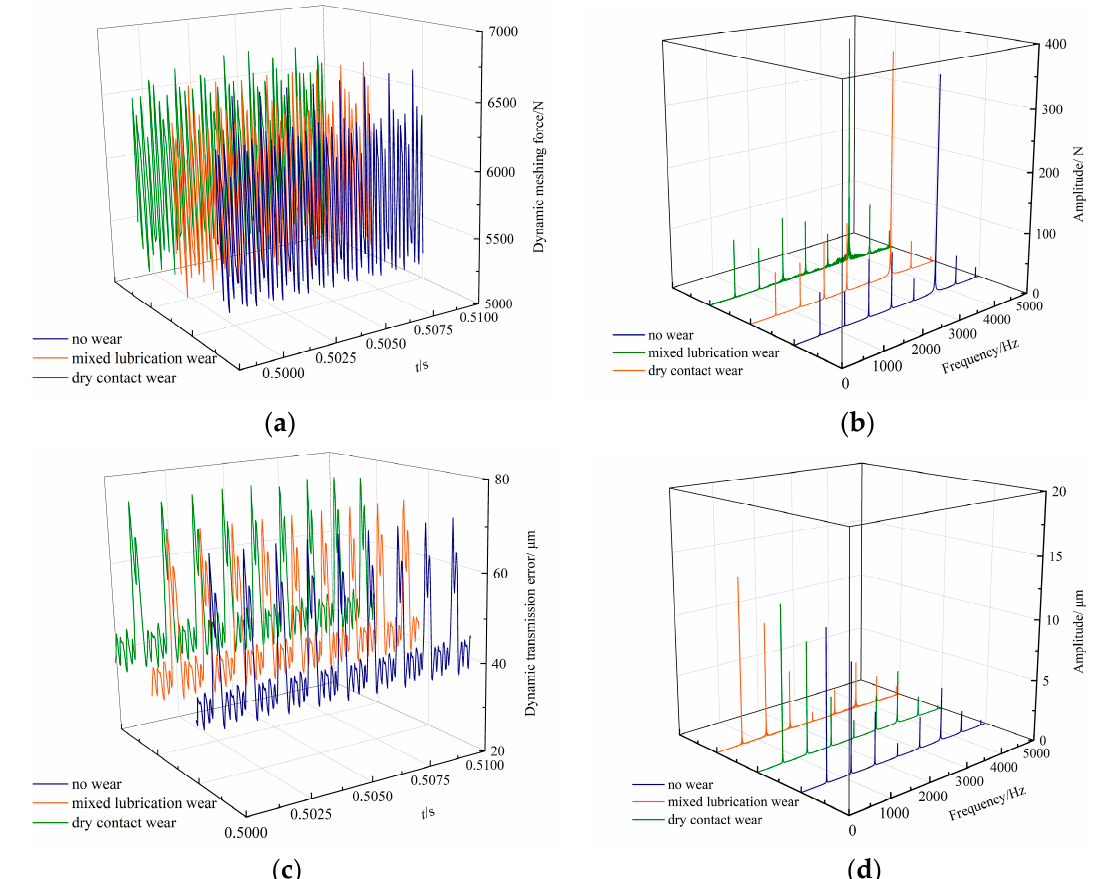
Figure 10. Variation of the DMF and DTE. ( a ) DMF. ( b ) Frequency domain spectrum. ( c ) DTE. ( d ) Frequency domain spectrum.